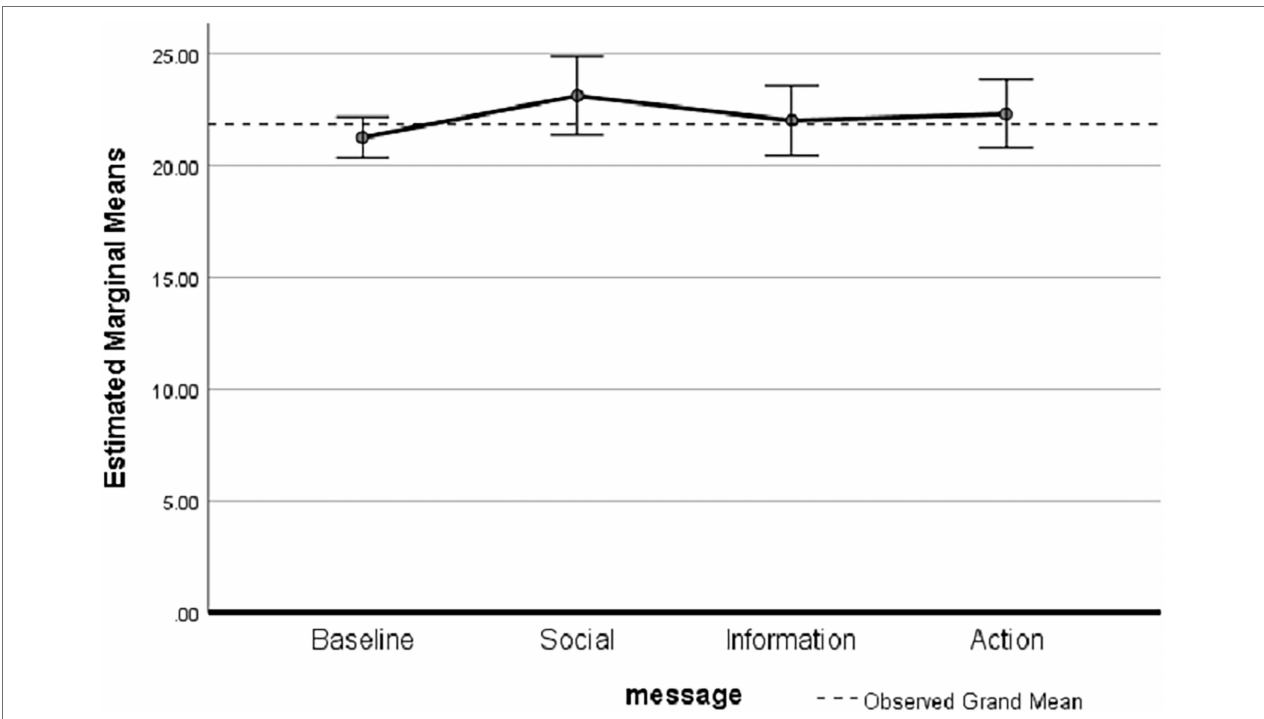
FIGURE 1 | Estimated marginal means between usage ratio and behavioral change technique (BCT) message groups ( p = 0.263; error bars = 95% CI, Covariates: hours = 12.04, weekday =